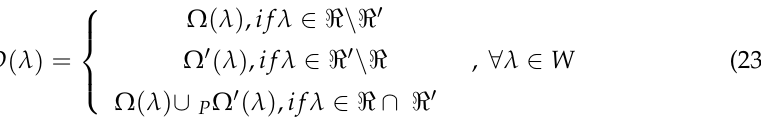
Figure 1. The description of Mr. X ’s opinion by ),( AF .